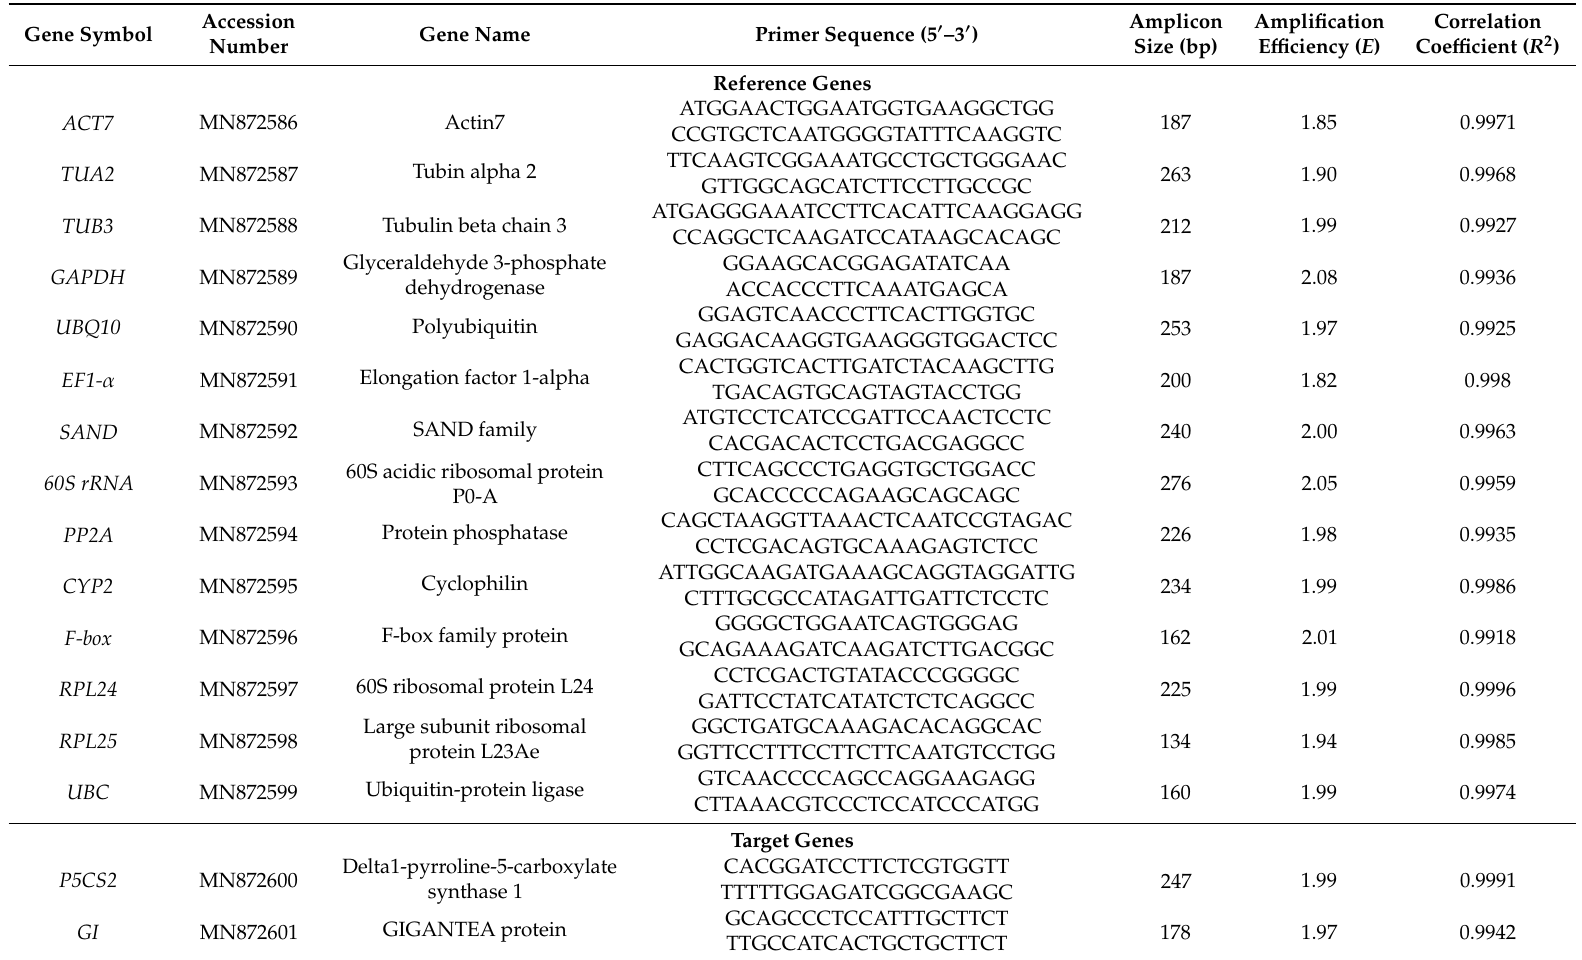
Table 1. Description of candidate reference genes (RGs) and target genes, primer sequences, product sizes, and amplicon